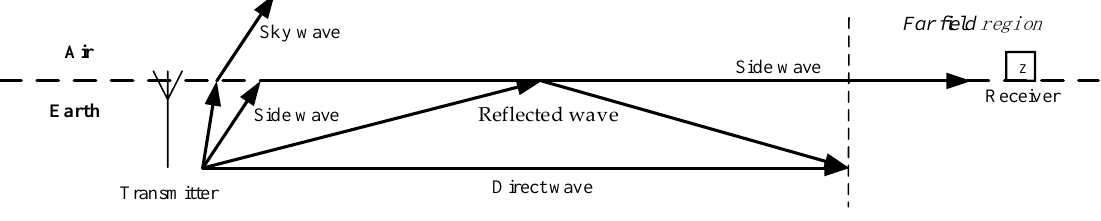
Figure 1. Electromagnetic wave transmission path.